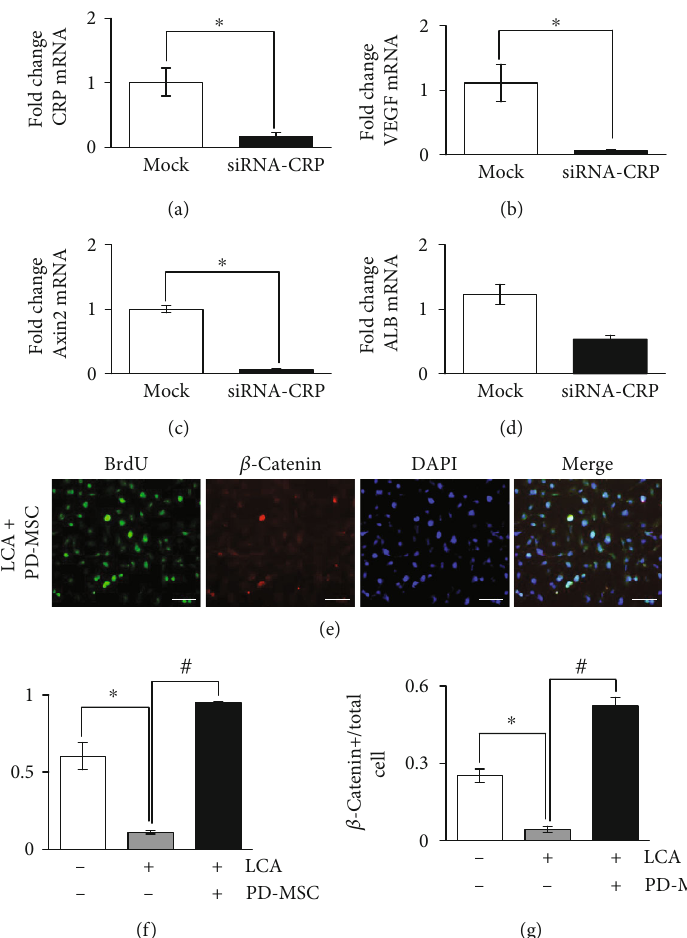
Figure 3: The direct e ff ects of CRP in WB-F344s. mRNA levels of CRP (a), VEGF (b), Axin2 (c), and ALB (d) were evaluated in siRNA-CRP- transfected WB-F344s by qRT-PCR. Representative images of immuno fl uorescence were stained with WB-F344s for β -catenin and BrdU after LCA treatment and cocultivation of PD-MSCs (e). Scale bars: 50 μ m. BrdU- (f) and β -catenin- (g) positive cells were counted ( n = 3 per group, ∗ control group and # LCA-treated group vs. p < 0 : 05 ). Data were represented as the mean ± SD . ALB: albumin; LCA: lithocholic acid-treated group; PD-MSC: PD-MSC cocultivated